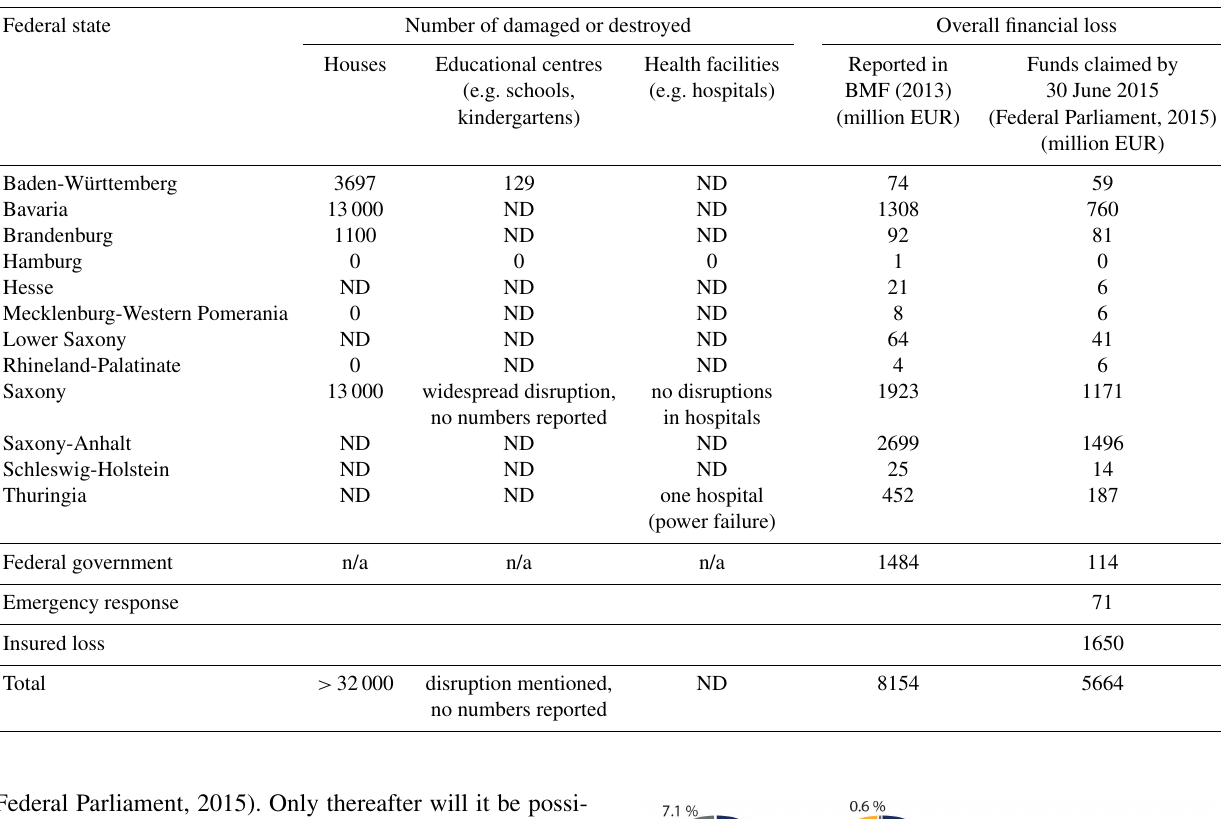
Table 2. Damage and loss indicators as recommended by Corbane et al. (2015) and IRDR (2015) available for the flood of June 2013 in Germany per federal state (data sources: BMF, 2013; Saxon State Chancellery, 2013; Brandenburg, personal communication, May 2014; Federal Parliament, 2015; ND: no data reported; n/a: not applicable).